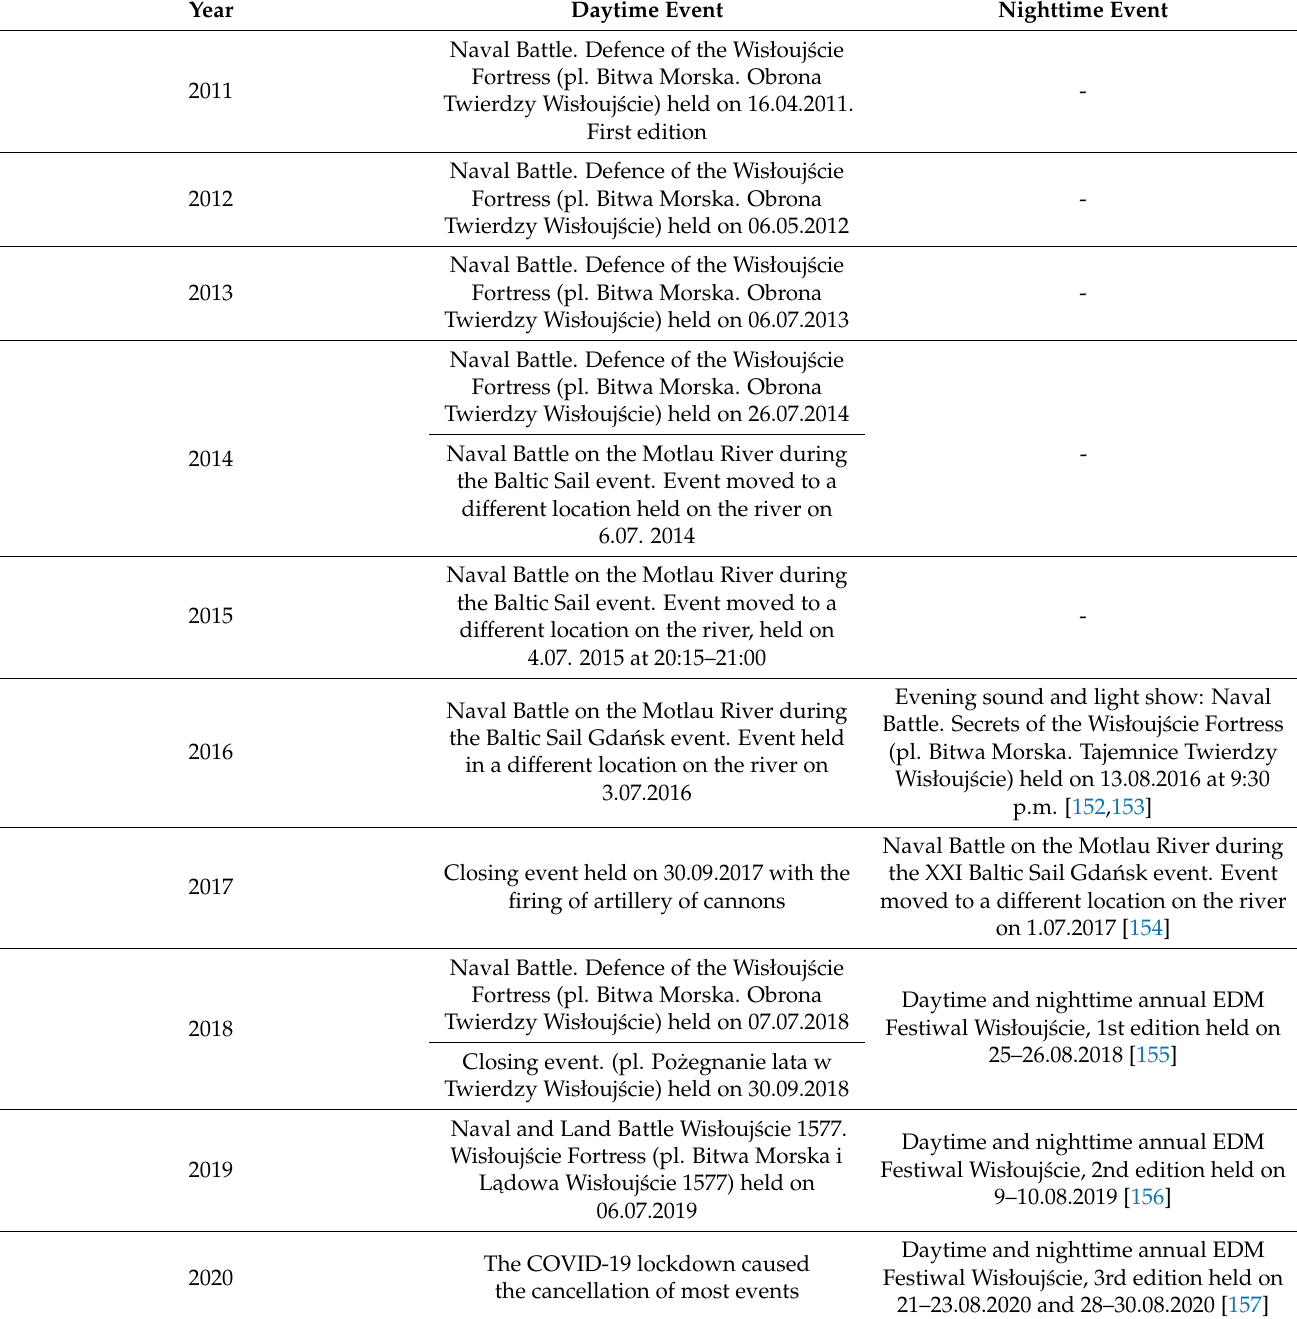
Table A1. An overview of the daytime and nighttime light and sound events between 2011 and 2020, organised on the site of the Natura 2000 Wisłouj´scie Fortress or on the adjacent river. Source: authors’